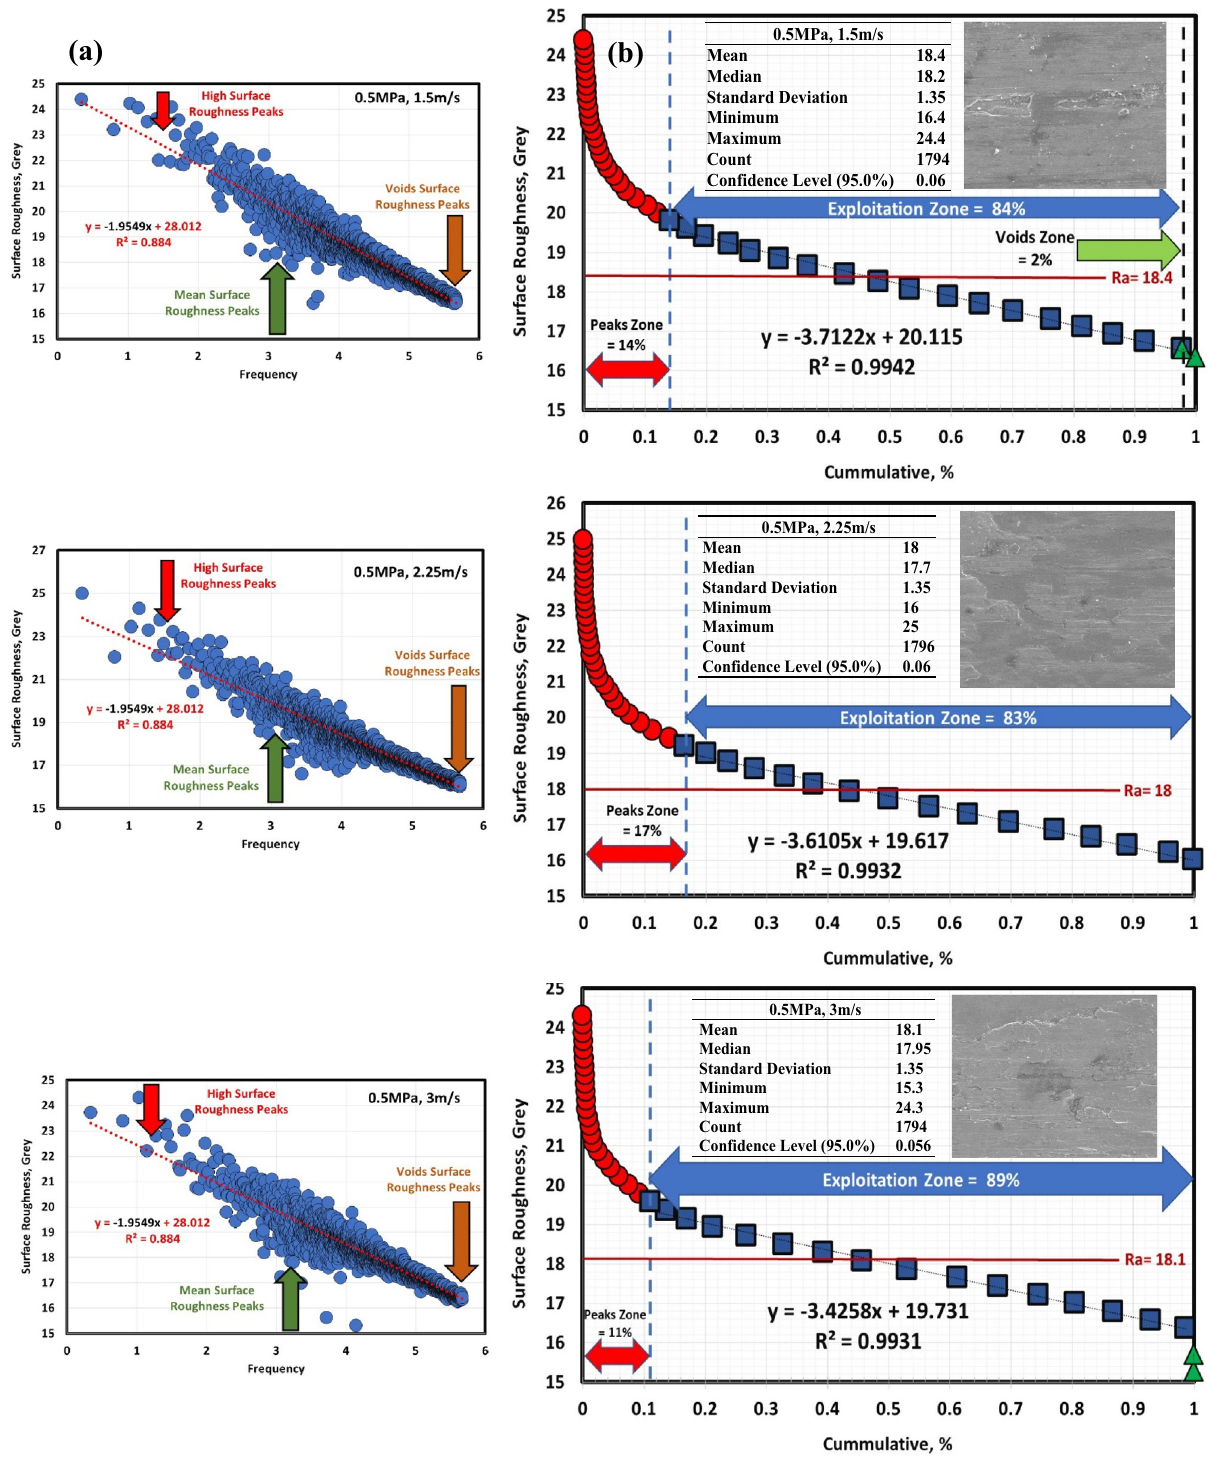
Figure 9. ( a ) Surface texture and ( b ) Abbott Firestone curves at 0.5 MPa and different velocities of QAM f